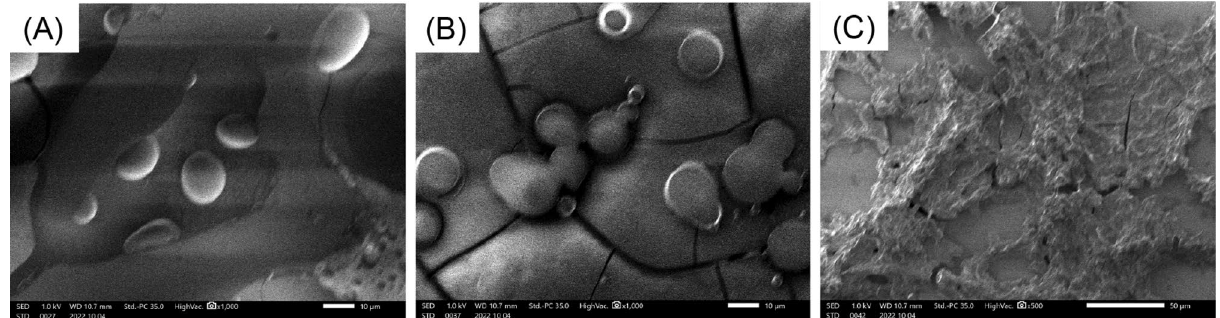
Figure 7. SEM image of self-assembled structures of truncated ELP analogues. SEM images of the self- assembled structures of ( A ) (FPGVG) 4 , ( B ) (FPGV) 4 , and ( C ) (FPG) 4 . The magnifications for the images are 1000 × for ( A ) and ( B ), and 500 × for ( C ).